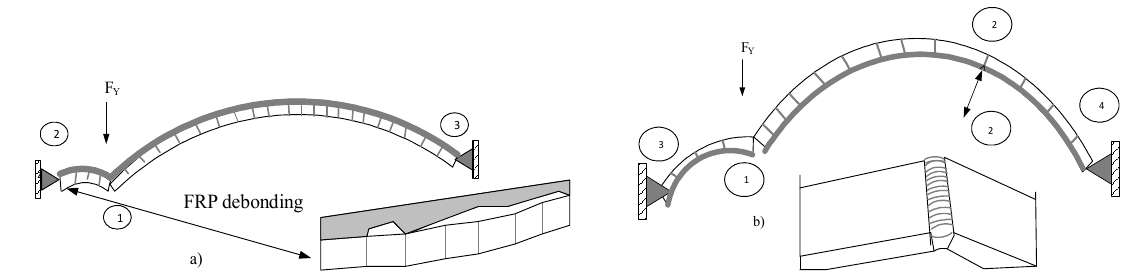
Figure 32. FMs in the strengthened vault, including the formation of four hinges: ( a ) at extrados and ( b ) intrados and rupture TRM [130].